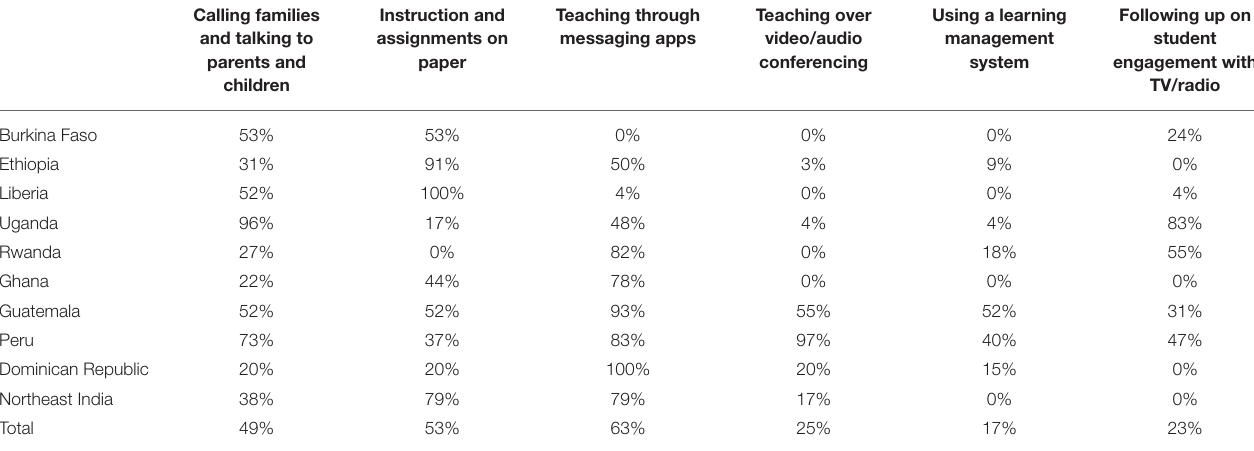
TABLE 7 | Educational supports